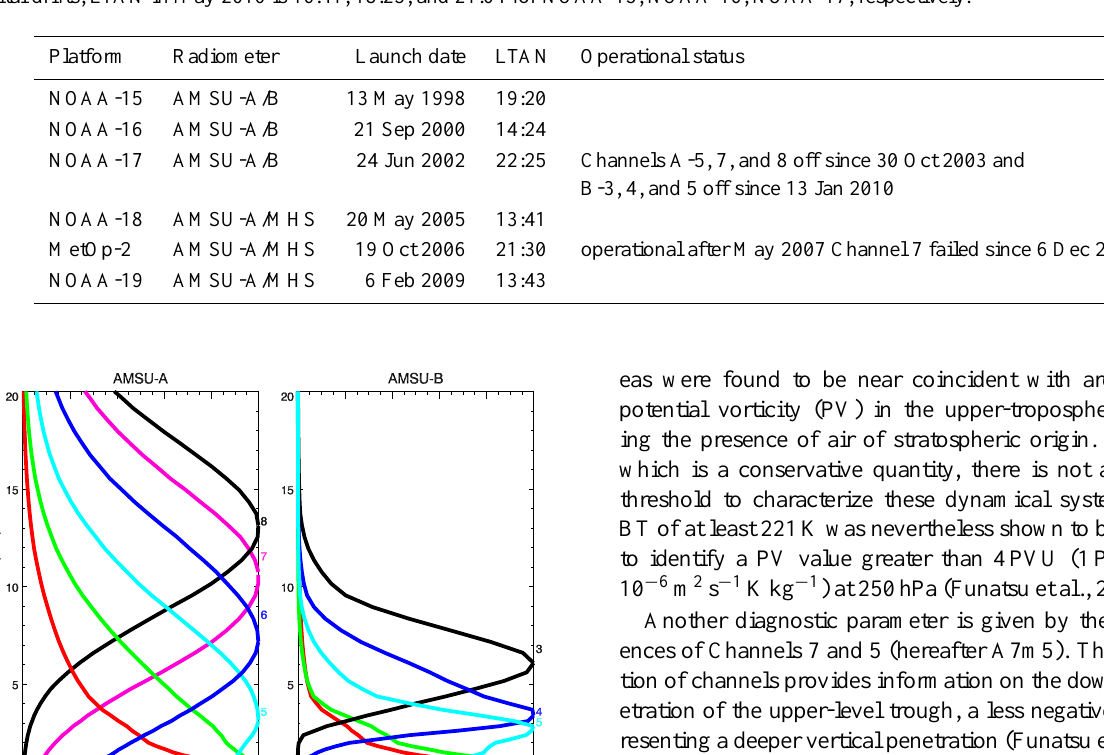
Table 2. List of platforms carrying AMSU radiometers and major characteristics: launch dates, status of AMSU-B/MHS channels and AMSU-A channels 5, 7, 8. LTAN is for Local Time Ascending Node. The value is given at the time of the launching of the satellite. Due to orbital drifts, LTAN in May 2010 is 16:41, 18:25, and 21:04 for NOAA-15, NOAA-16, NOAA-17, respectively.